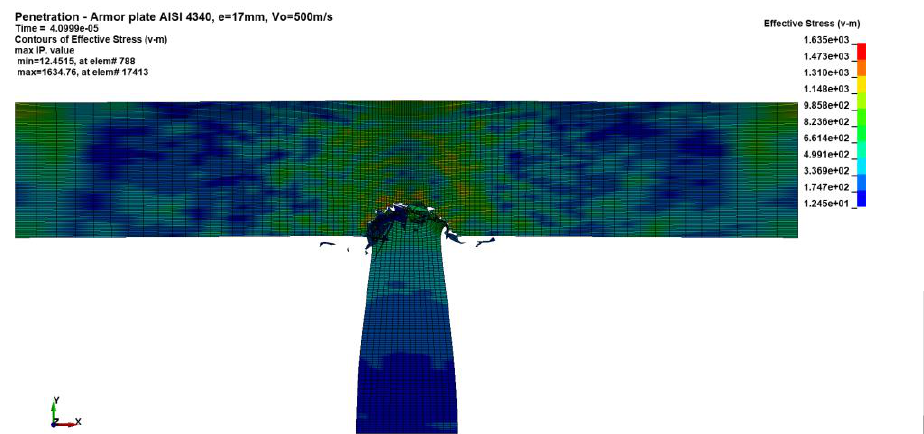
Figure 18 – Von Misses equivalent stress, time of analysis 0.04 ms – Model 3 Рис. 18 – Von Misses эквивалентное напряжение, время анализа 0.04 ms – Модель 3